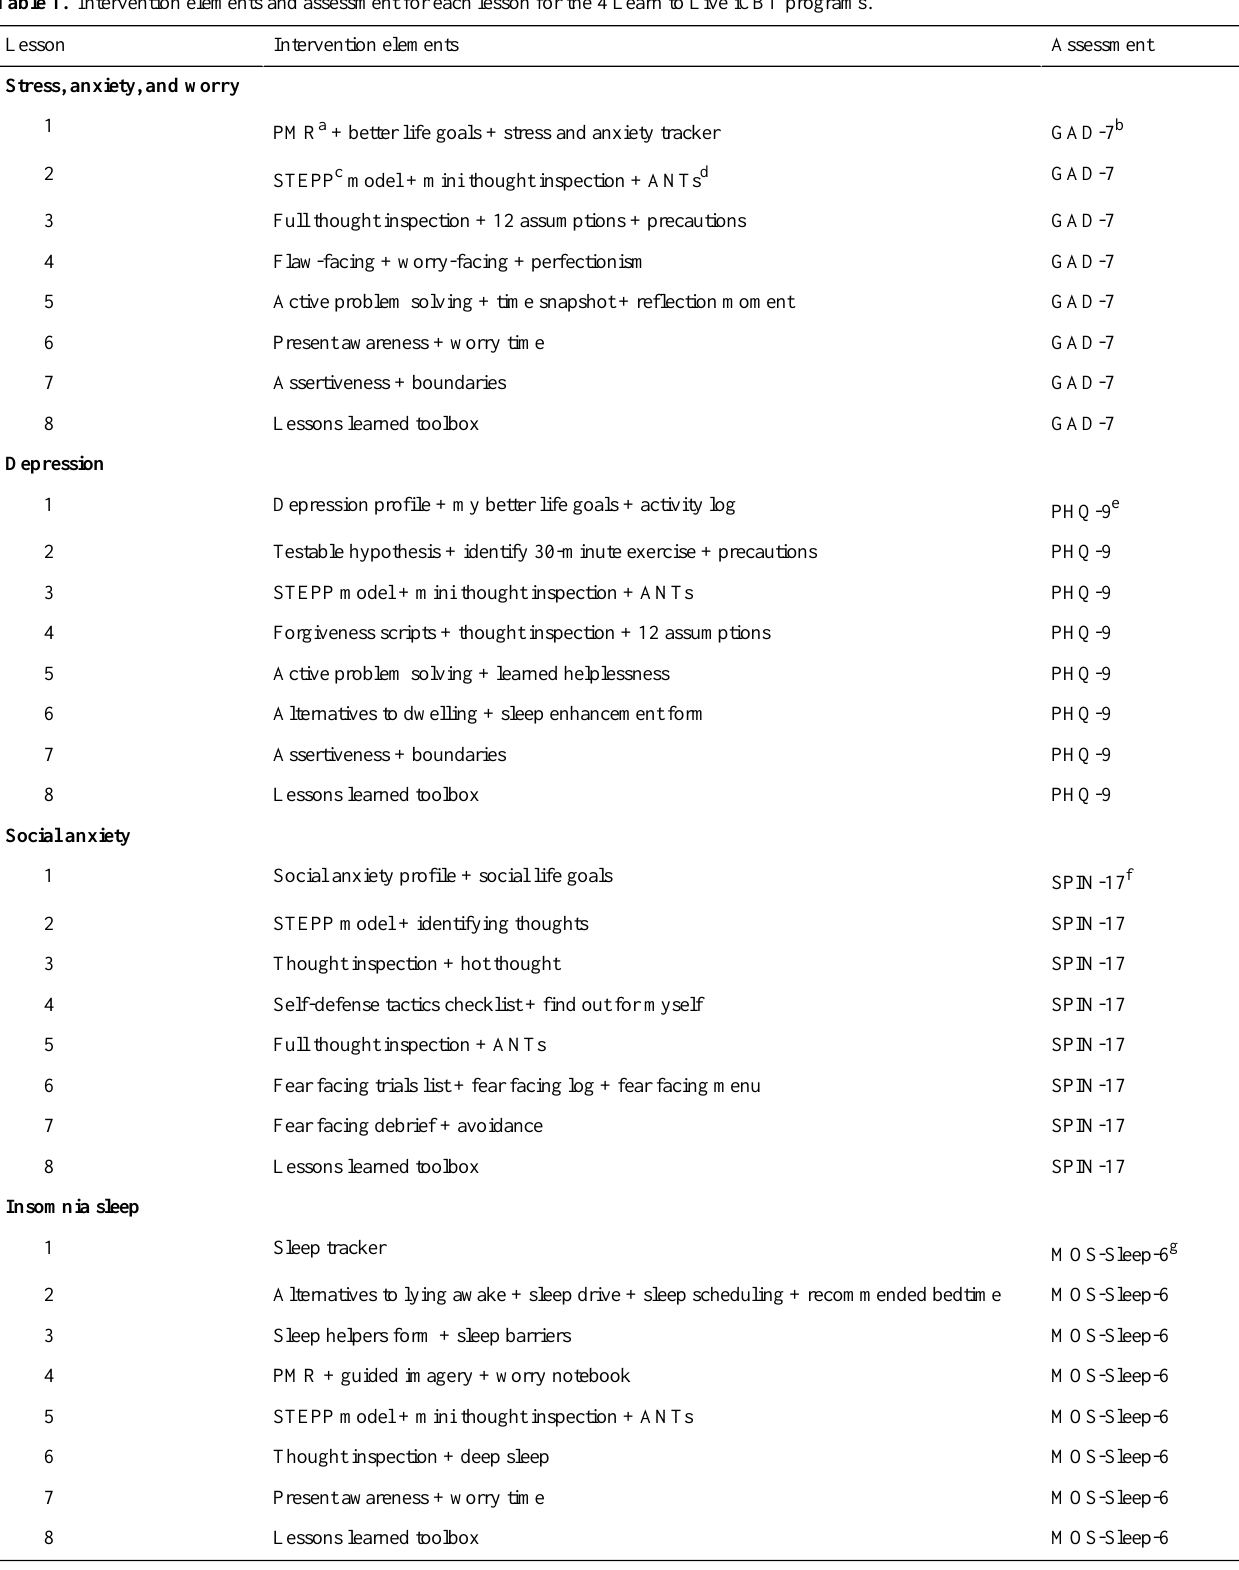
Table 1. Intervention elements and assessment for each lesson for the 4 Learn to Live iCBT programs. AssessmentIntervention elementsLesson Stress, anxiety, and